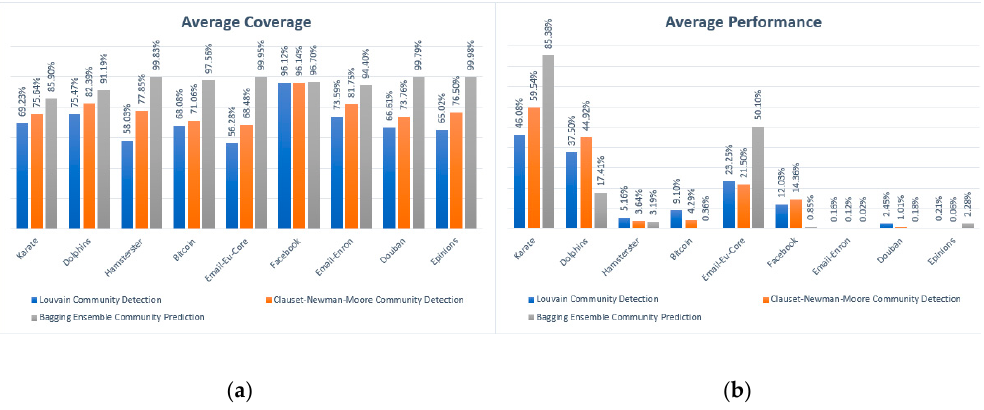
Figure 3. Qualitative performance comparison of the bagging community prediction methodology (grey columns) against the Louvain [10,22] (blue columns) and Clauset–Newman–Moore [3,25] (orange) community detection algorithms. ( a ) Average coverage per applied method; ( b ) Average performance per applied method.